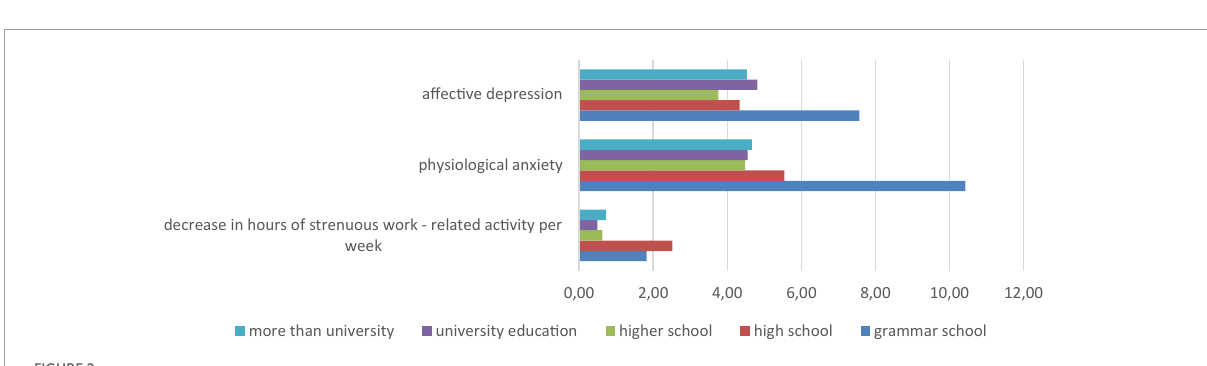
FIGURE2 Significant differences in participants with different education in changes in physical activity (PA) during epidemic and anxiety and